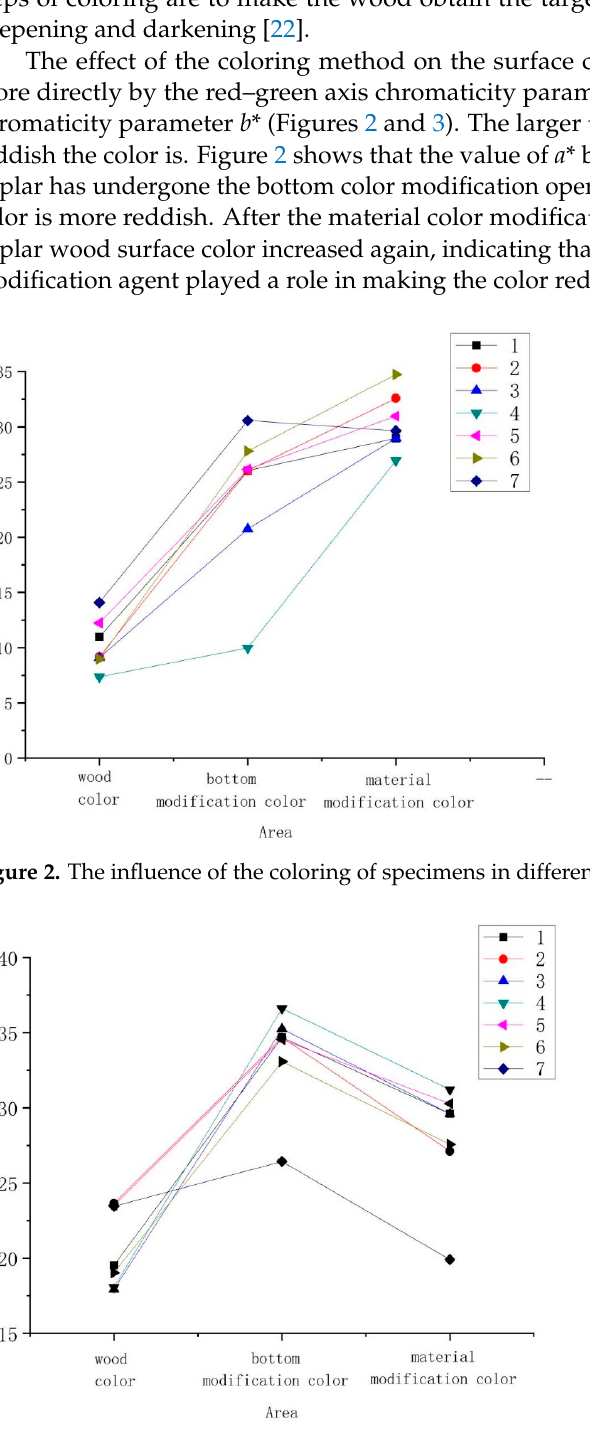
Figure 3. The influence of the coloring of specimens in different regions on b *. C * indicates the degree of color saturation, and Figure 4 shows the color saturation of the specimen. The bottom color modification obviously improves the saturation of the color, while the material color modification has no obvious effect on the further saturation of the color.